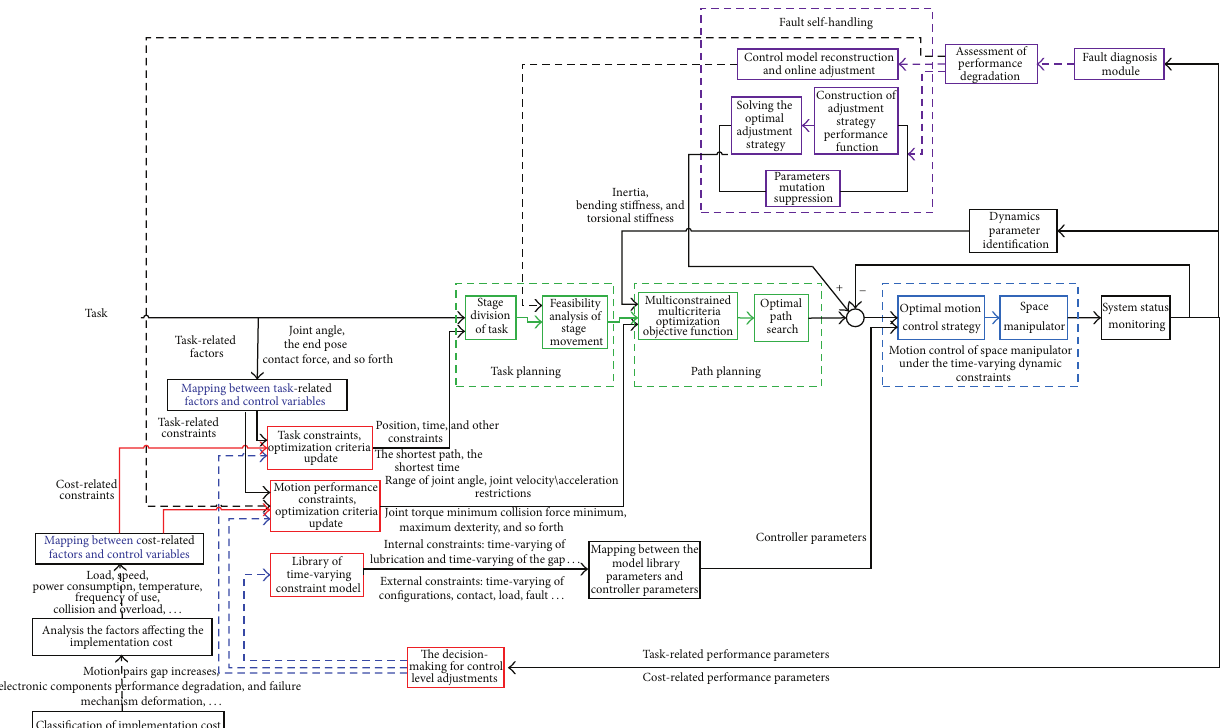
Figure 2: The operational reliability system control model of space